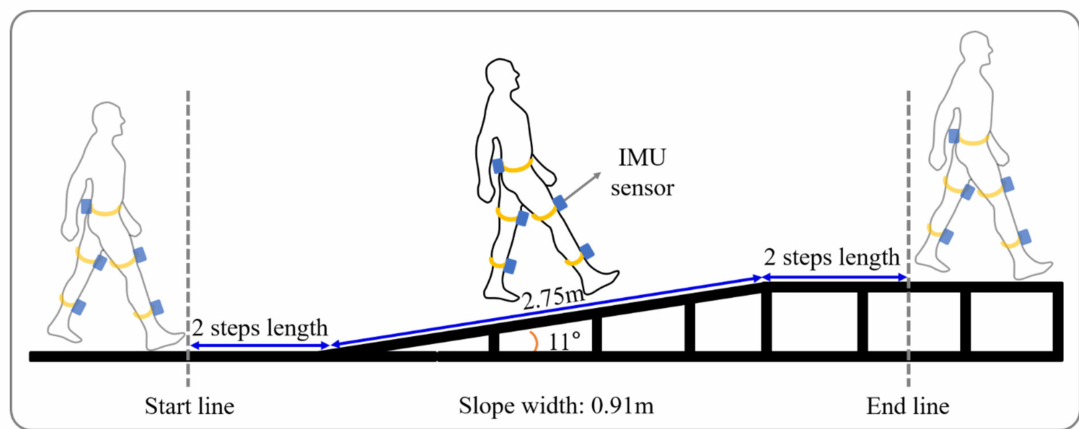
Figure 1. Schematic diagram of ramp